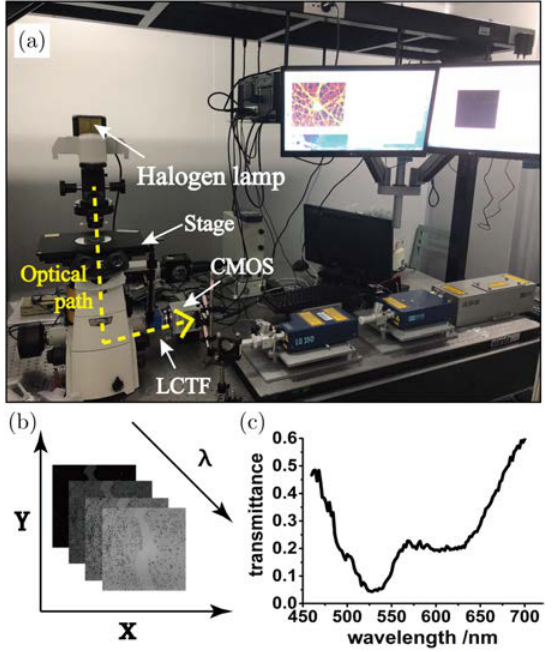
Fig. 1. HIS system and data that obtained using it. (a) Hyperspectral microscopy system. (b) Data cubes obtained using shown system. x and y represent spatial dimensions while (cid:1) represents spectral dimension. (c) Transmission spectrum at random pixel in